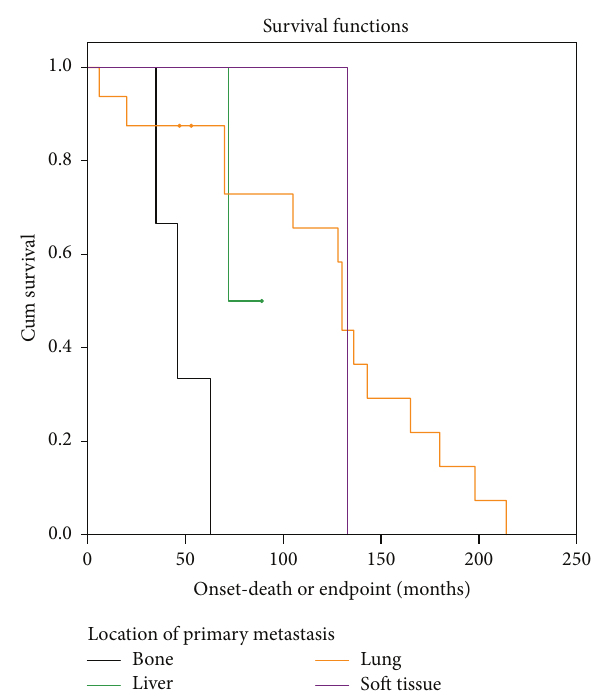
Figure 3: Survival distribution among patients with metastasis stratified by location of metastatic disease. Diamonds represent censored data